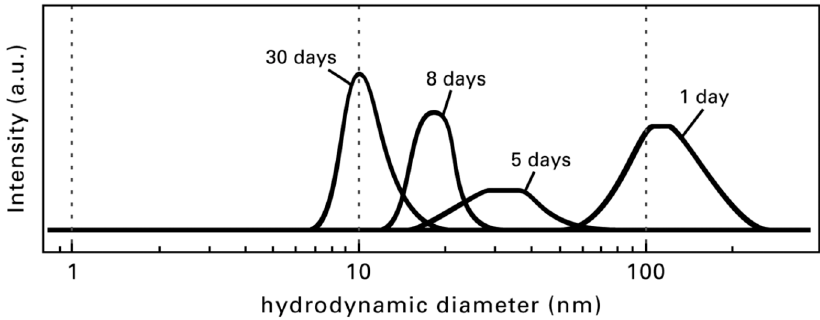
Figure 6. Particle size distribution measured by DLS depending on the sol age. Reproduced from Reference [37] with the permission of the Royal Chemical Society.